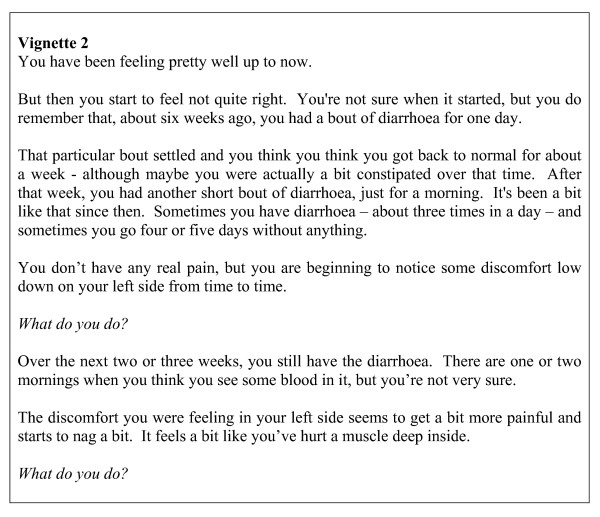
Example of vignette.